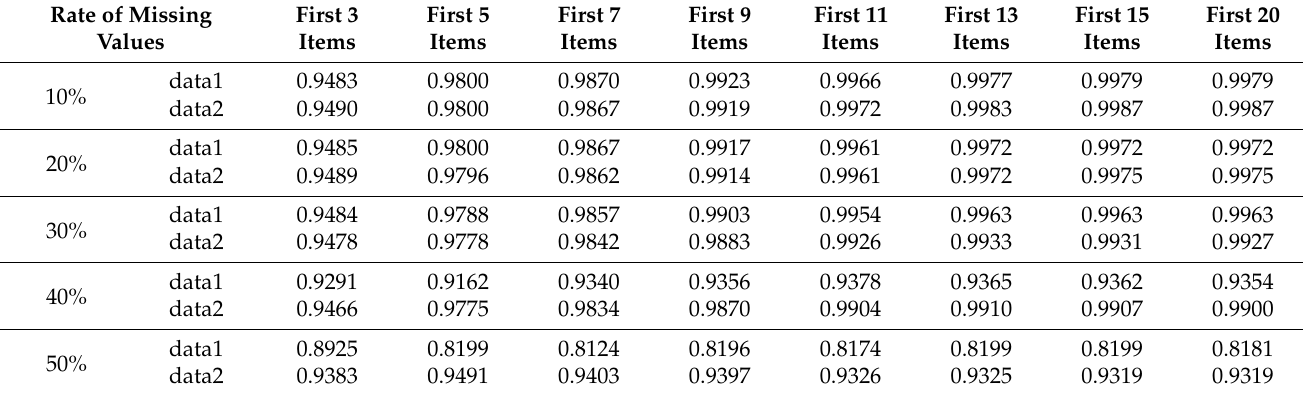
Table 1. Correlation between different reconstruction items and the original series (R 2